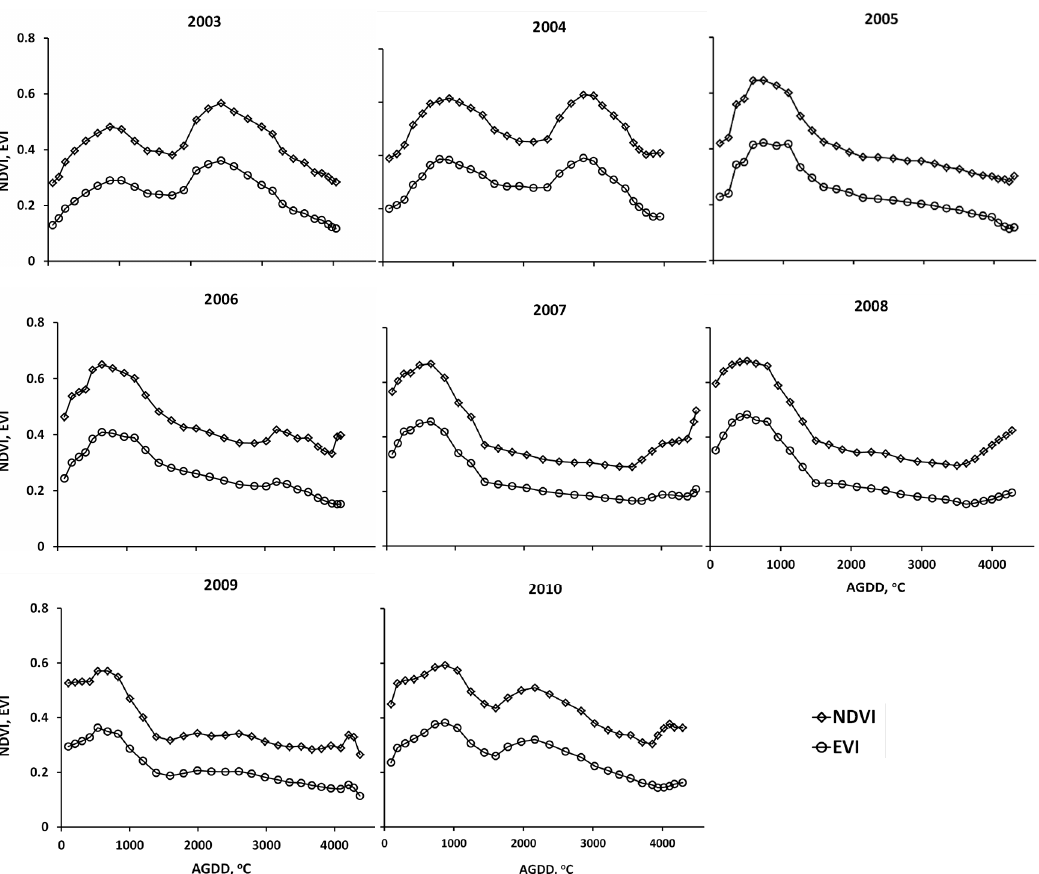
Figure 10. NDVI and EVI interannual variability in one of the southernmost study sites (Simferopol, Ukraine at 45.6 ◦ N) from 2003–2010. Whether due to changes in cultivation practice or crop failures, the VI curves change from bimodal (2003–2004) to unimodal (2005–2009) and back to bimodal (2010).